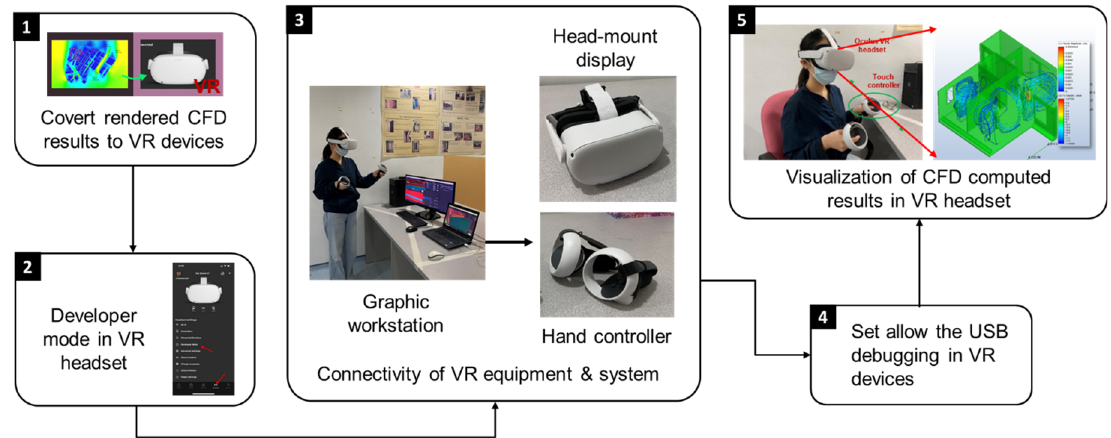
Figure 8. Steps for setting up an immersive virtual environment.